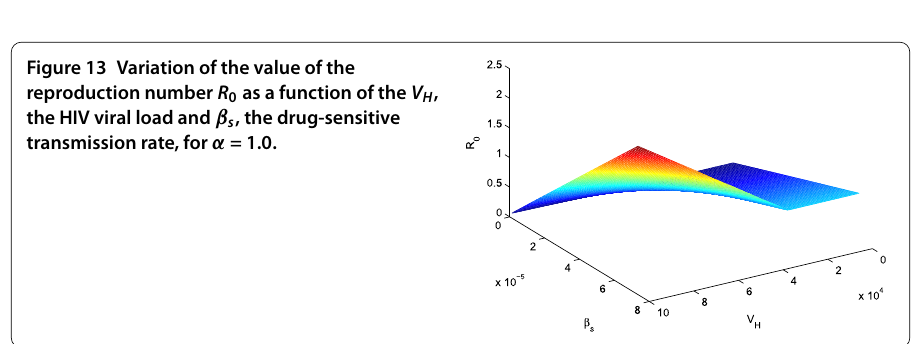
Figure 12 Dynamics of the variables of system (1) for different values of s H , the CD4 + T cells recruitment rate, and α = 0.7. Parameter values are in Table 1 and initial conditions are given in the text.